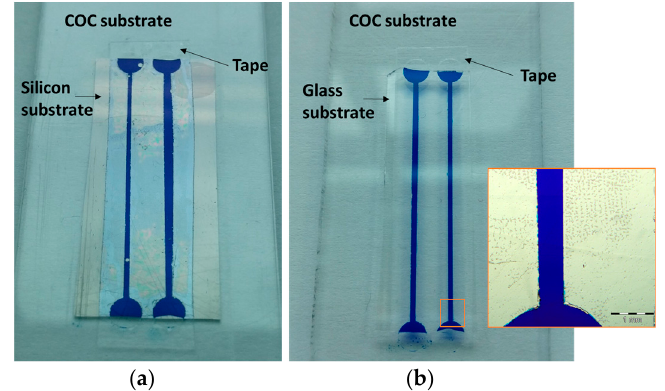
Figure 3. Leakage tests realized in bonding samples by using colored DI water. The ps UV laser structured tape joins the COC polymer substrate to ( a ) the blank silicon substrate and ( b ) the blank glass substrate. Note that, the tape joins both substrates perfectly where the water flows smoothly through the channel without leakages (see inset